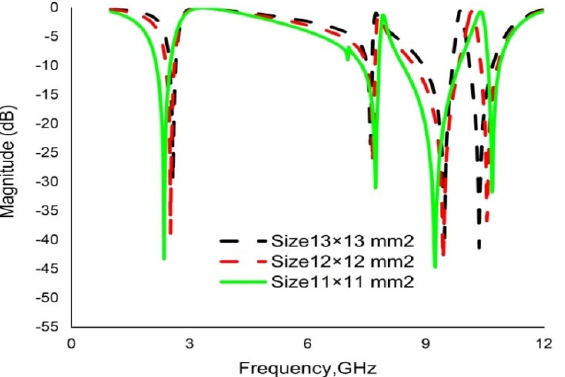
Figure 5. Transmission coefficients ( 𝑺 𝟐𝟏 ) for different sizes of unit cell substrate.